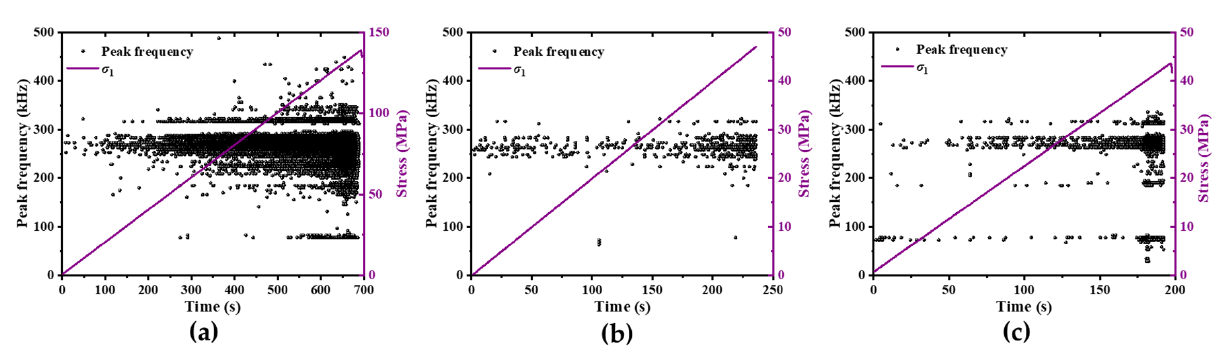
Figure 12. Peak frequency and stress variation with time in the biaxial compressive tests with σ 2 = 10 Mpa: ( a ) granite, ( b ) marble, and ( c ) sandstone.